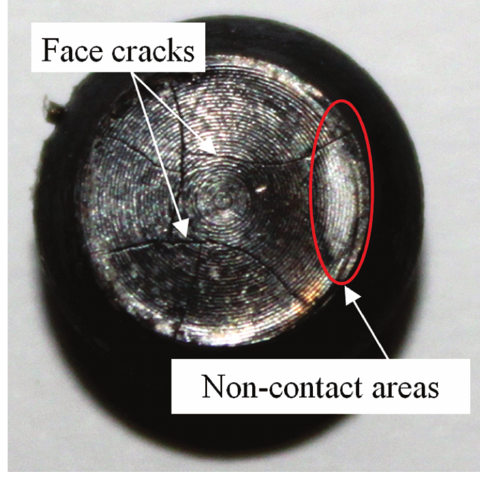
Figure 6: The forming process for (a) upsetting without resistance heating, (b) upsetting with